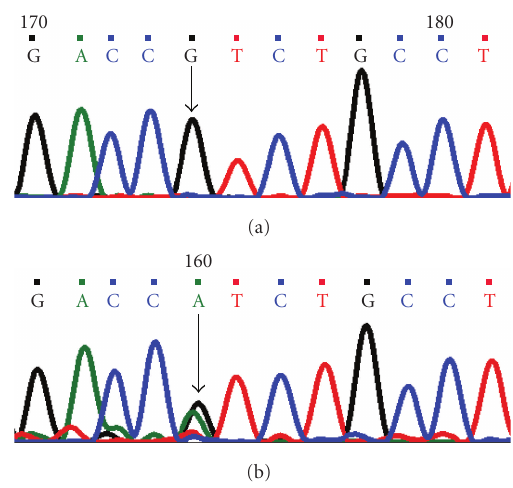
Figure 4: DNA sequence chromatogram of CYP1B1 exon 3 equivalent to codon 367–370. (a) The reference sequence derived from control is shown. (b) Sequence derived from ARS patient shows heterozygous c.1103G > A, which predicts a codon change from CGT > CAT and heterozygous p.R368H